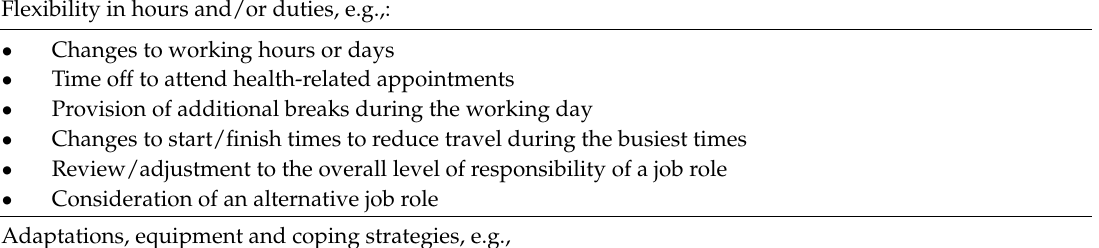
Table 3. Recommendations for Work Adjustments (fromBritish Society of Rehabilitation Medicine [11]). Flexibility in hours and/or duties,